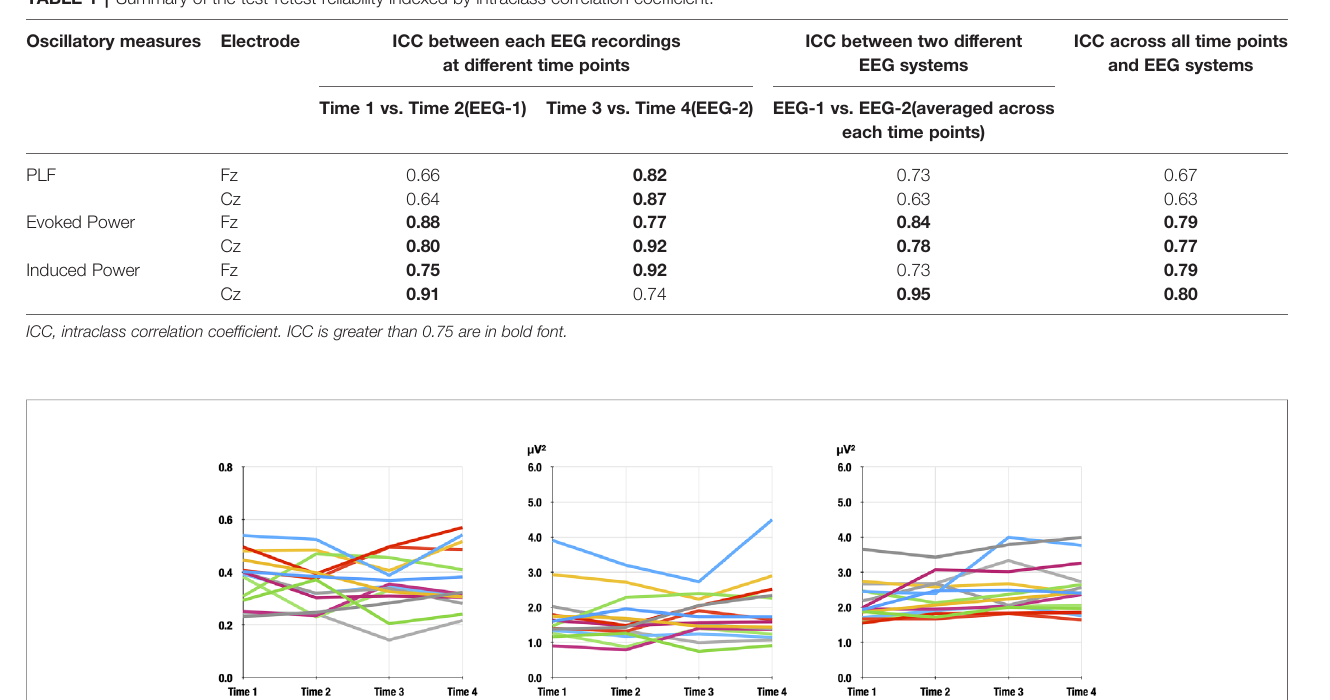
ICC between two different ICC across all time points EEG systems and EEG systems